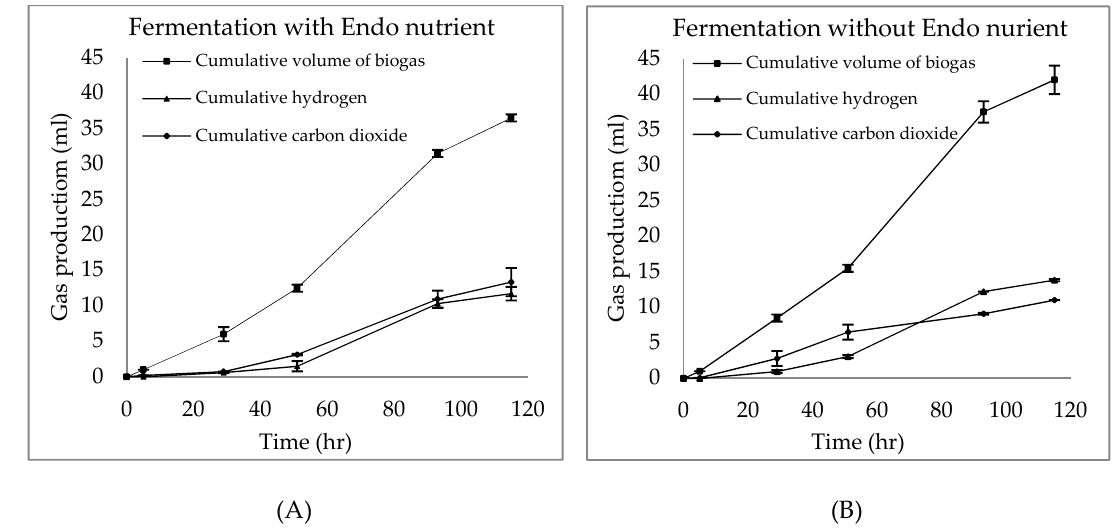
Figure 1. Cumulative gas production (hydrogen and carbon dioxide) from Chlorella sp. in batch fermentation with (A) and without (B) Endo nutrient.